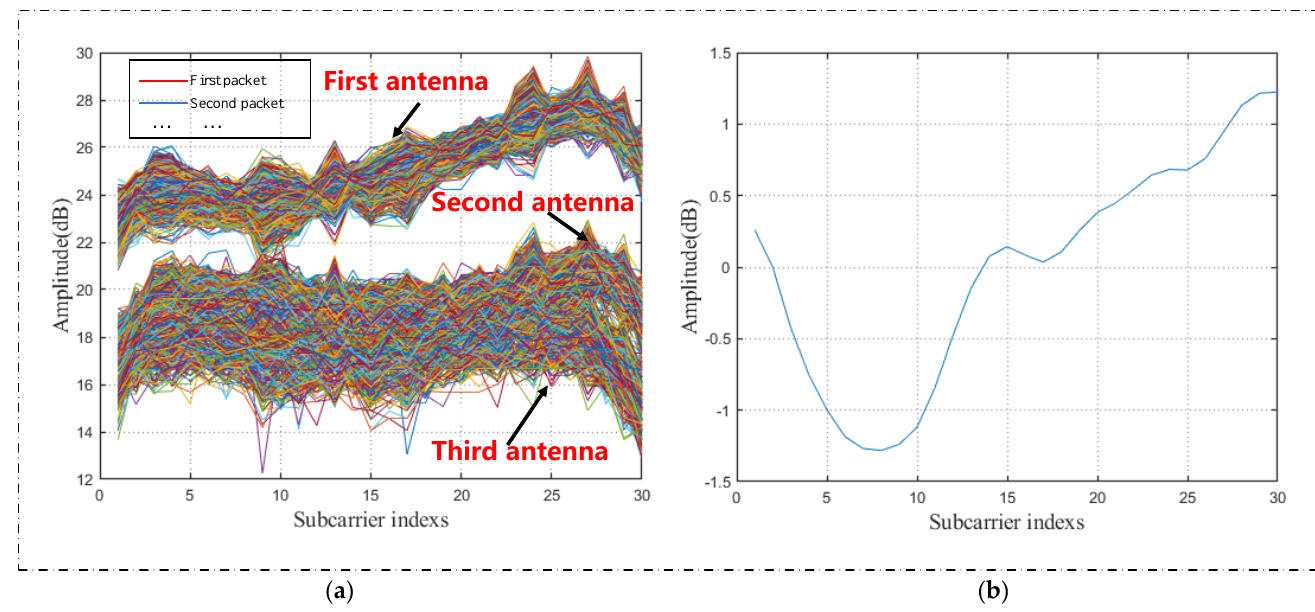
Figure 5. CSI waveform of the yoga pose. ( a ) Original CSI waveform; ( b ) CSI waveform after pre-processing.